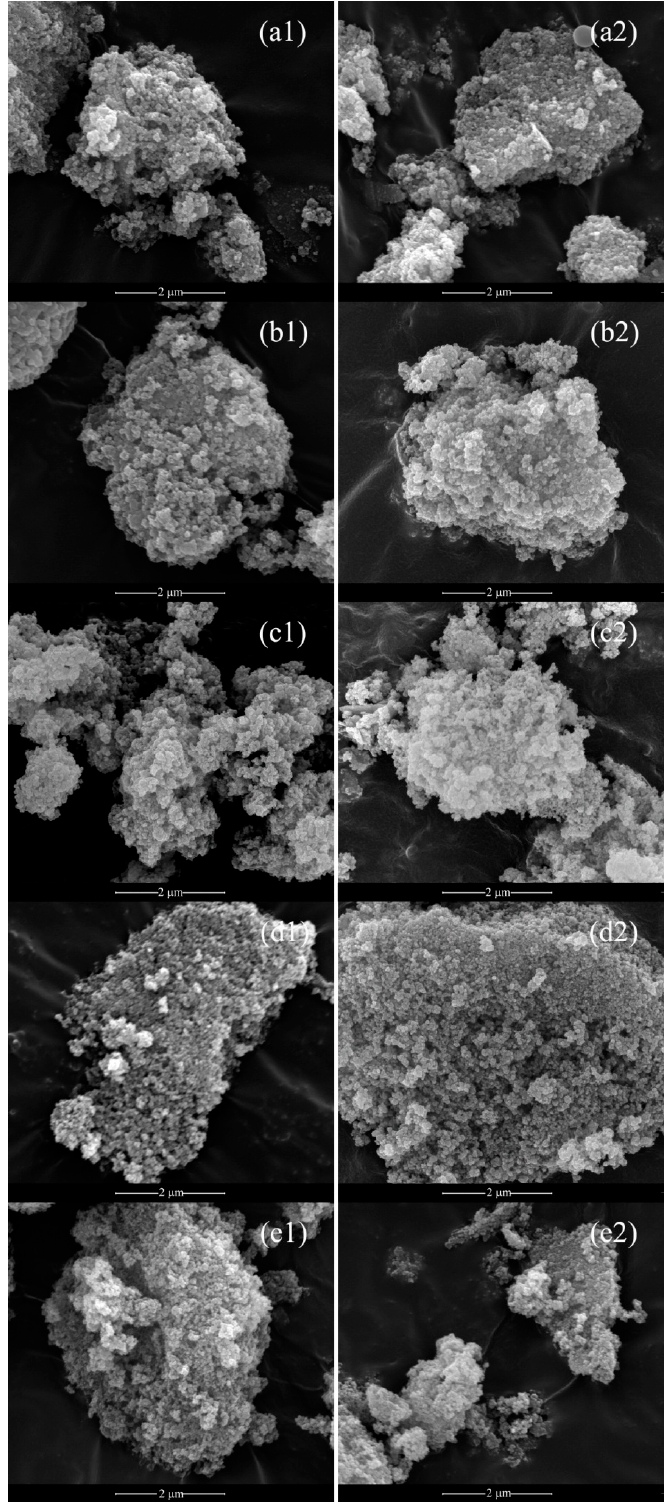
Figure 4. SEM micrographs at magnification of 50000X of as-synthesized (1) and calcined samples (2): a = C, b = GDC20, c = SDC20, d = GPrDC20, and e = SCaDC20.